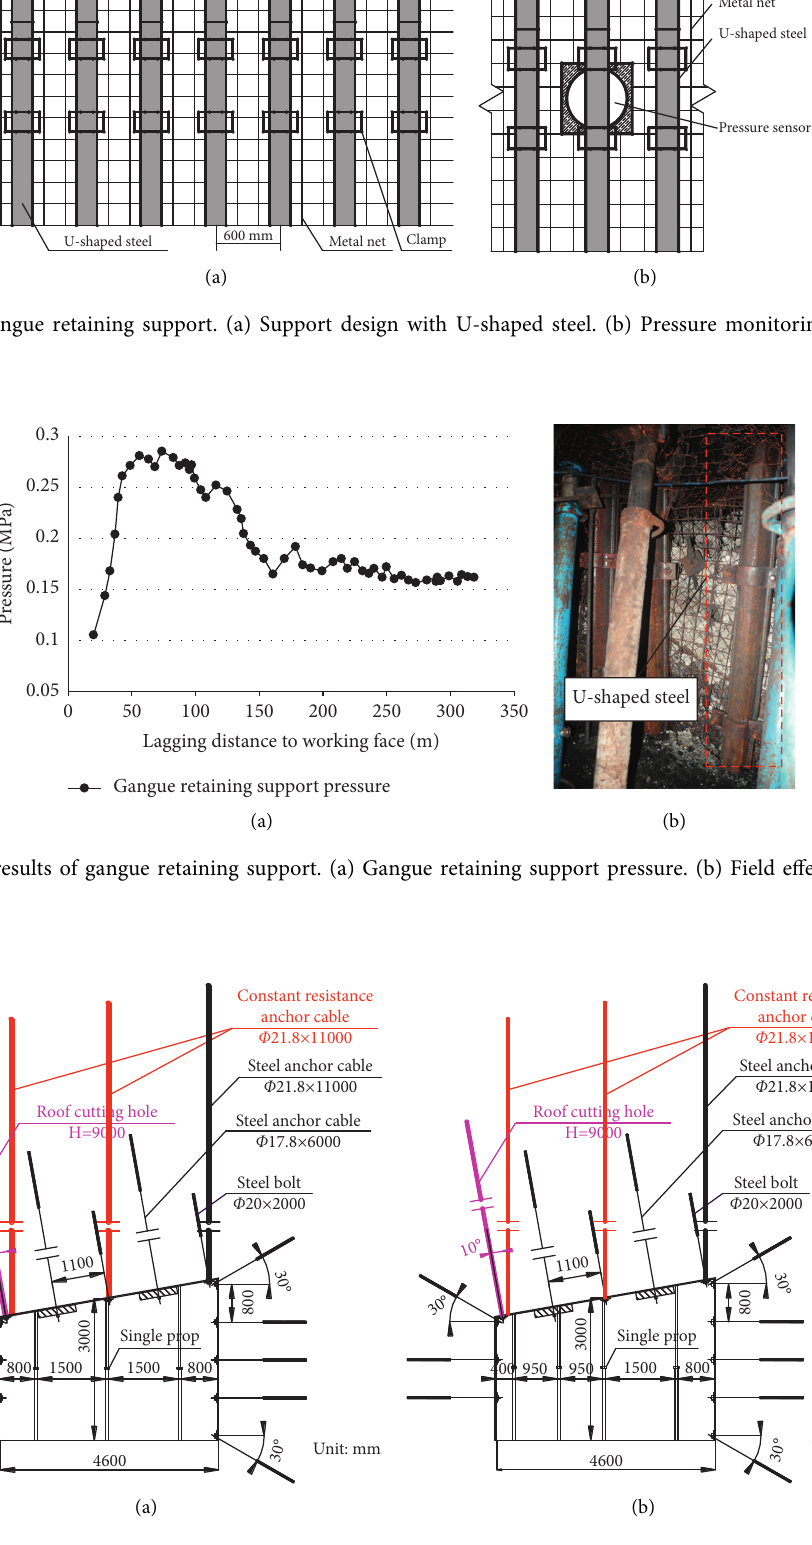
Figure 13: Advance and lagging temporary support design of the 43073 working face. (a) Advance temporary support. (b) Lagging temporary